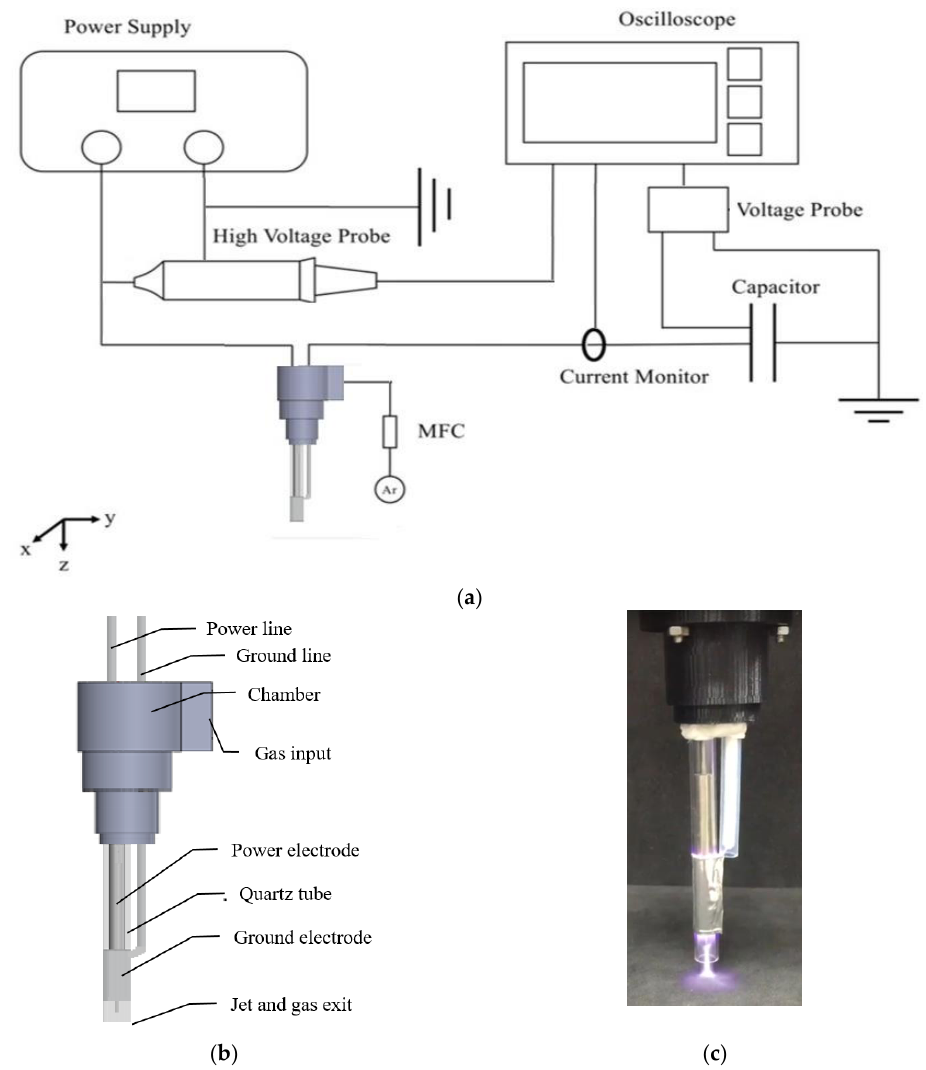
Figure 1. ( a ) Schematic of system including an APPJ device and electrical measurement devices; ( b ) schematic of the APPJ device; and ( c ) snapshot of the APPJ device with the generated plasma jet.